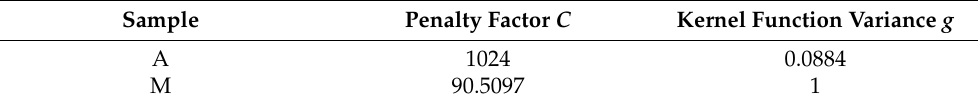
Table 11. The best parameters C and g